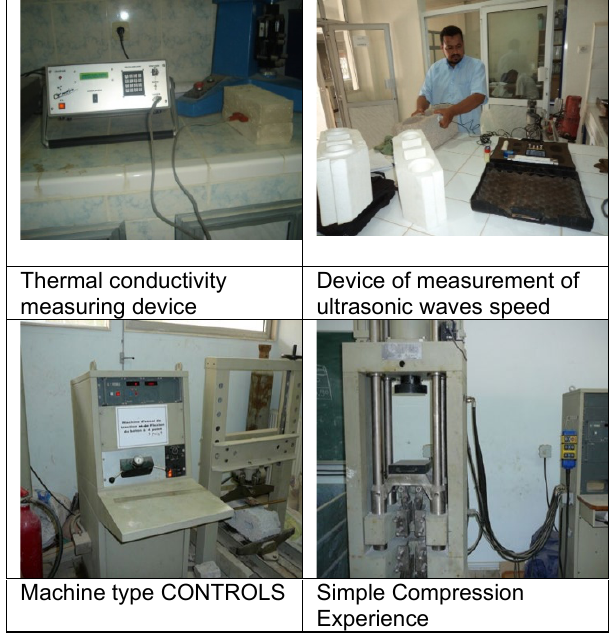
Figure 3. (a): Tensile bursa with three-point